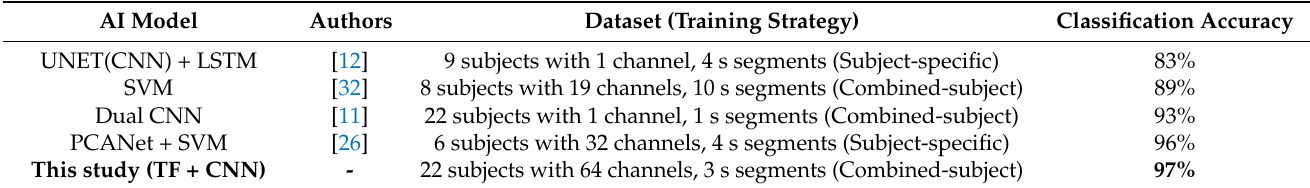
Table 3. Mental fatigue classification methods